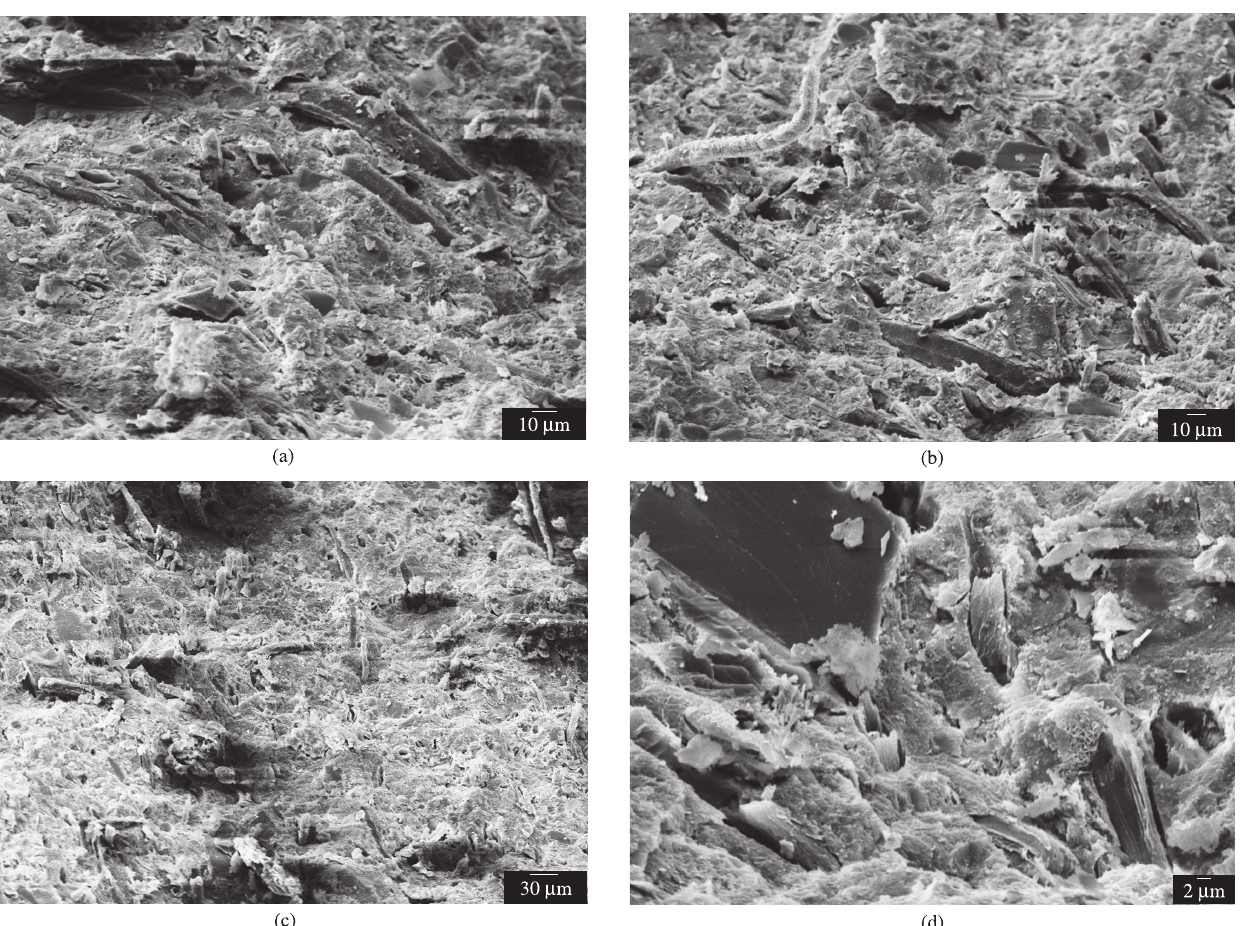
Figure 7. SEM of fracture surface of composites reinforced with: a) and b) sisal organosolv pulp after 100 soak/dry cycles; c) and d) sisal kraft after fast carbonation followed by 100 soak/dry